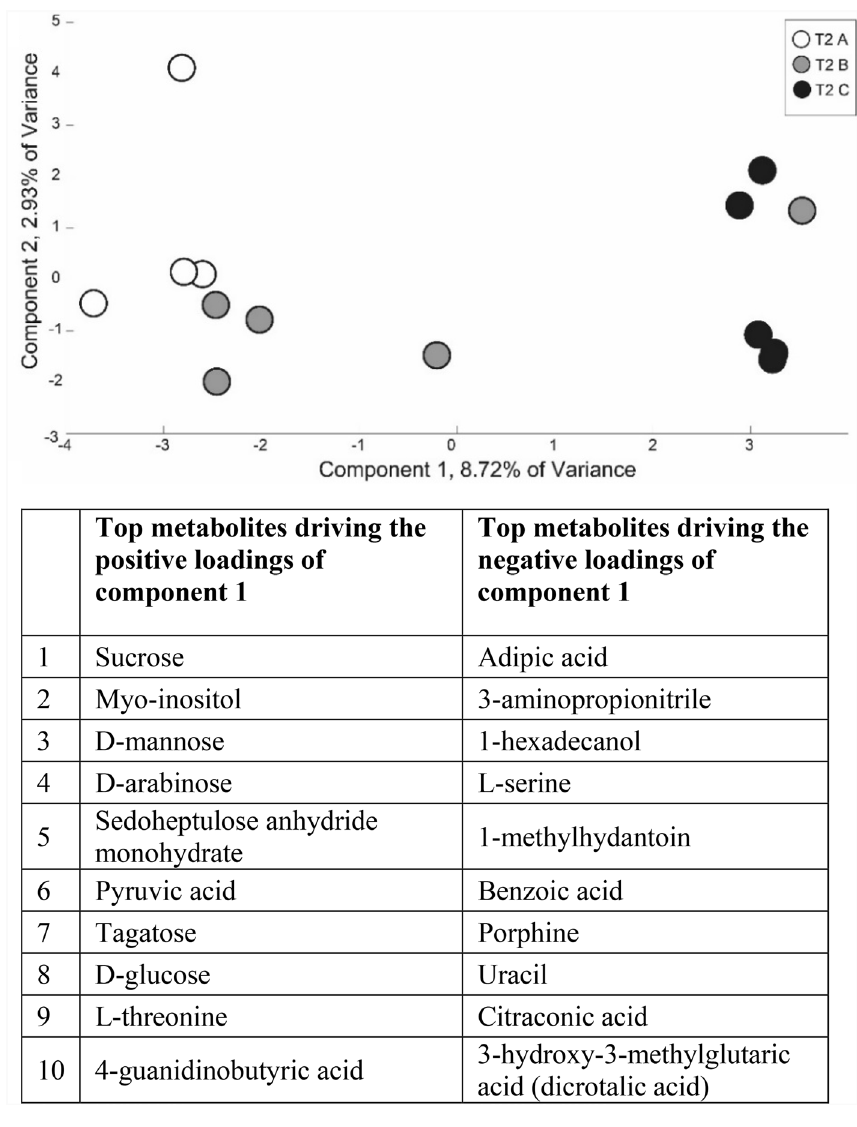
Figure 3. GC–MS-identified root exudate compounds associated with driving the treatment separation, reflecting the drought severity treatment gradient. GC–MS probabilistic PCA (pPCA) loadings and scores of treatments A (control), B (mild), and C (severe) after treatment (T2). Table lists the top ten metabolites driving the positive and negative pPCA loadings of component